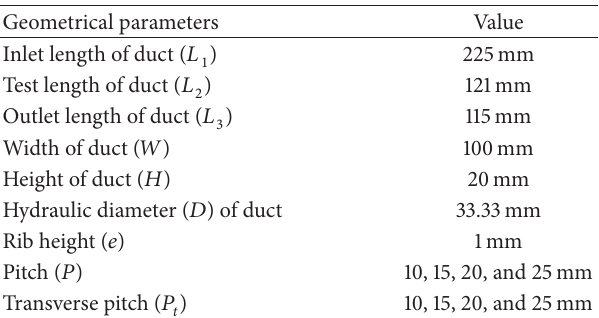
Table 1: Geometrical parameters for both geometries used in artificially roughened solar air heater duct.